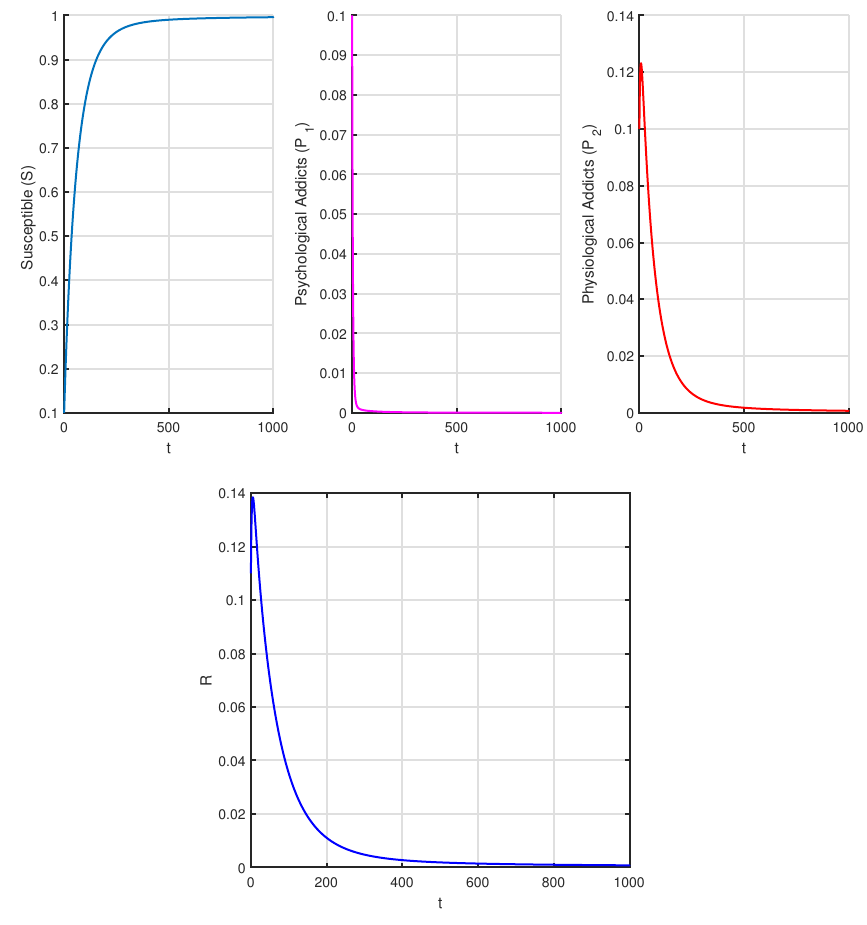
Figure 2. Time series of system (3) corresponds to Table 2 when E 0 = ( 1,0,0,0 ) and R 0 =